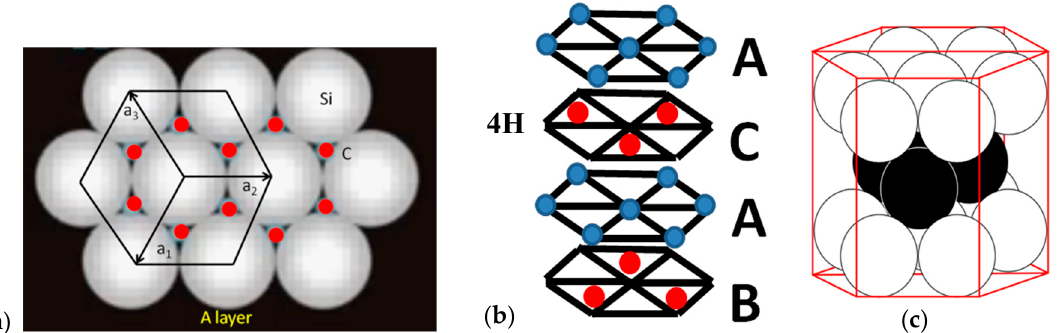
Figure 1. ( a ) Stacking sequence ACAB of 4HSiC crystal: red dots indicate the position of the following atomic layer shown in ( b ) at layers C and B; ( c ) 3D perspective of three initial layers.